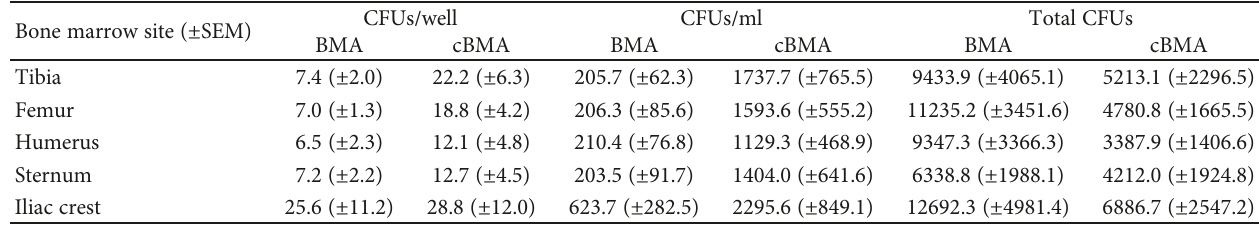
Table 1: Colony-forming units (CFUs) among the di ff erent bone marrow sites before (BMA) and after (cBMA) concentration with the Magellan.